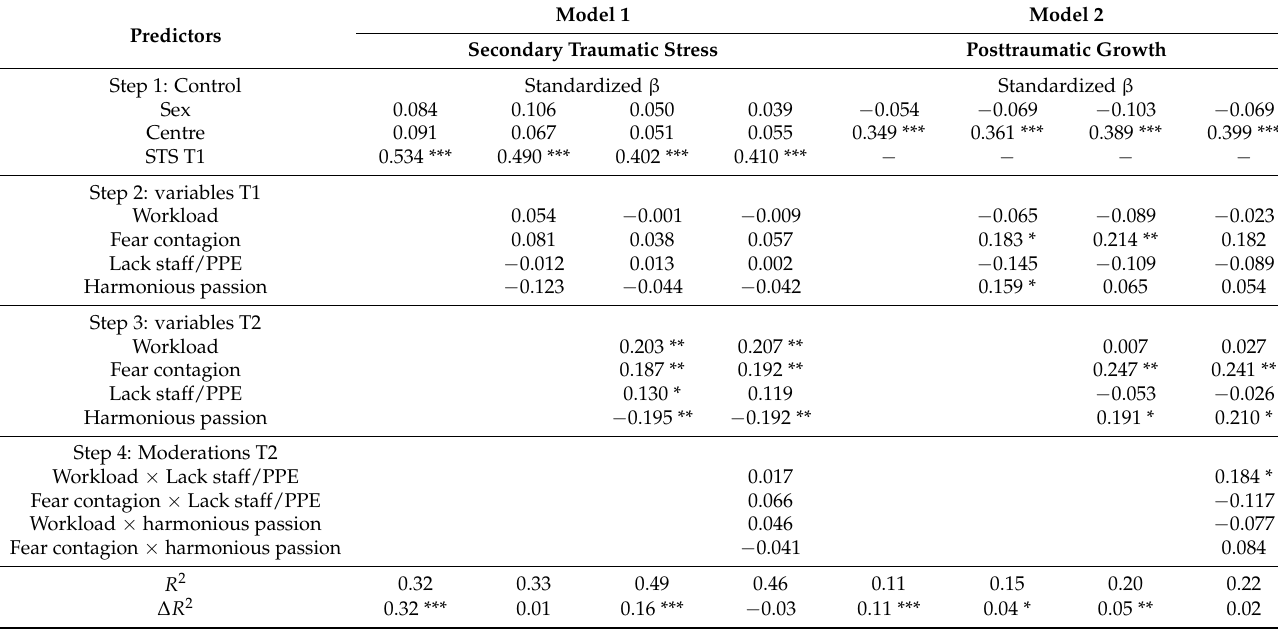
Table 4. Hierarchical regression model on criterion variables of Secondary Traumatic Stress and Posttraumatic